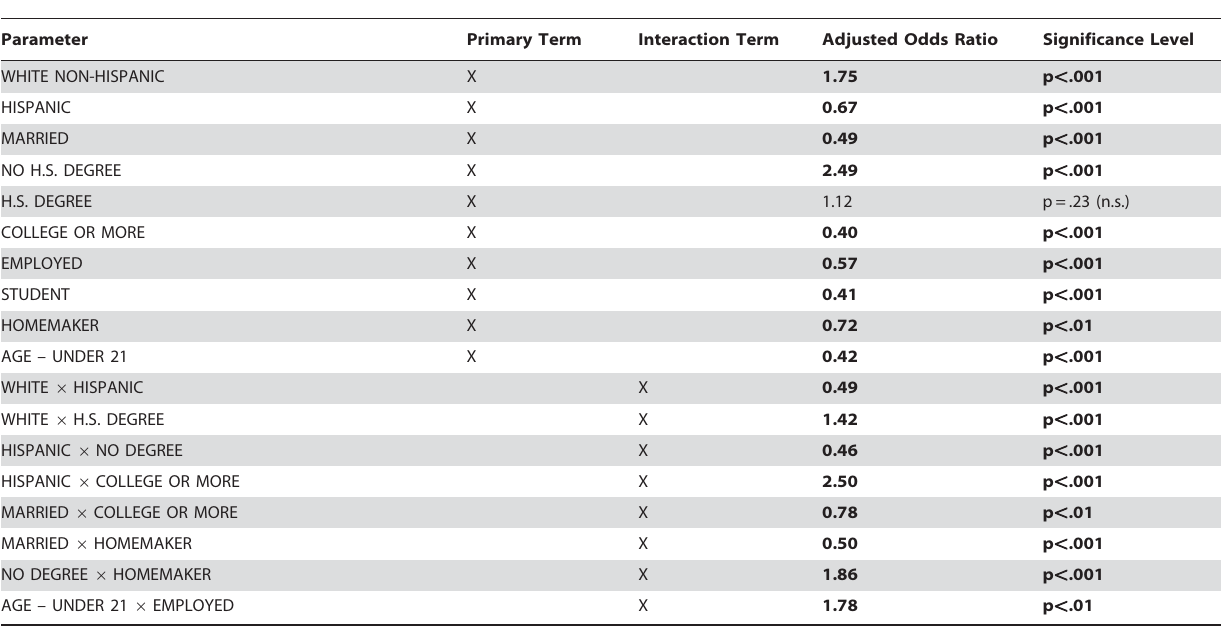
Table 1. Adjusted odds ratios for BRFSS likely smoker model (Massachusetts BRFSS: 1997–2004).